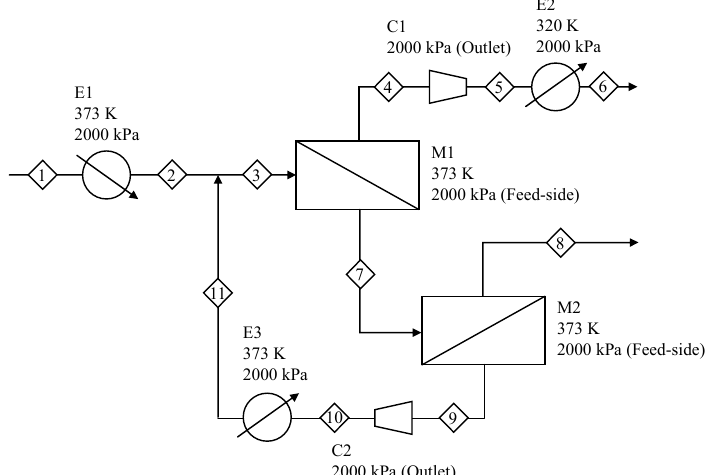
Figure 2. Schematic of the membrane-separation process. E: heat exchanger, M: membrane unit, C: compressor. Table 2. Feed conditions and product requirements of the membrane-separation process used in this study.